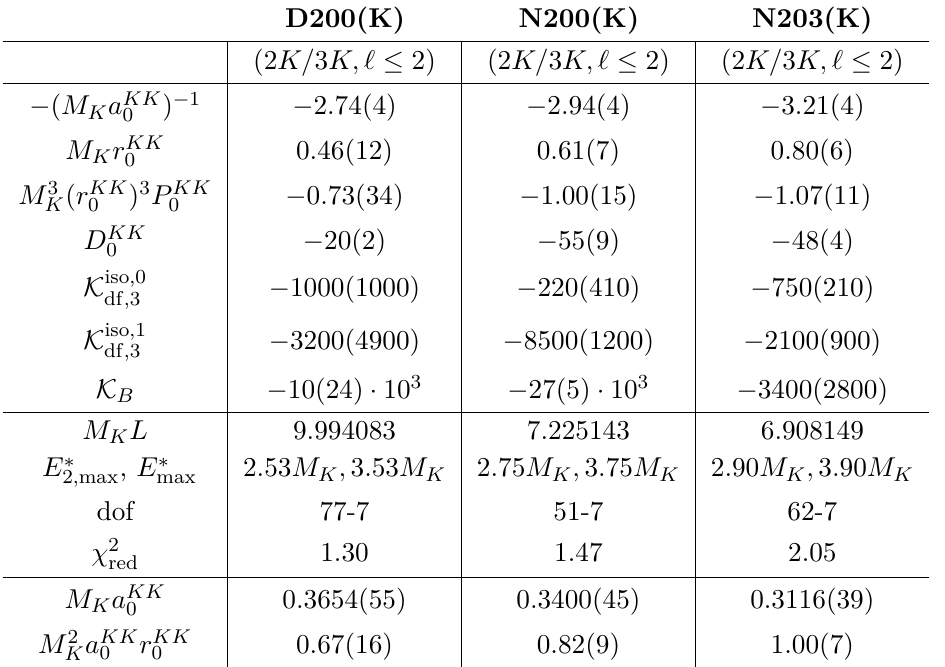
Table 14. Fit results for kaons using the ERE form of the s -wave phase shift. Here M K L is a fixed input to the quantization condition, as in table